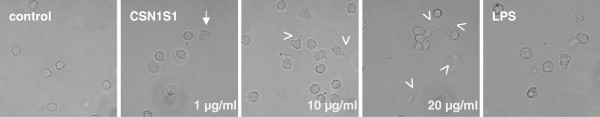
Live primary human monocytes stimulated with CSN1S1. Primary human monocytes were incubated with CSN1S1 for 24 h with increasing CSN1S1 concentrations in comparison to medium control and 200 ng/ml LPS. Living cells were photographed at 400× magnification. Cells developed irregular cytoplasm (arrow) and pseudopodia (arrow-head). Representative pictures of 10 experiments.